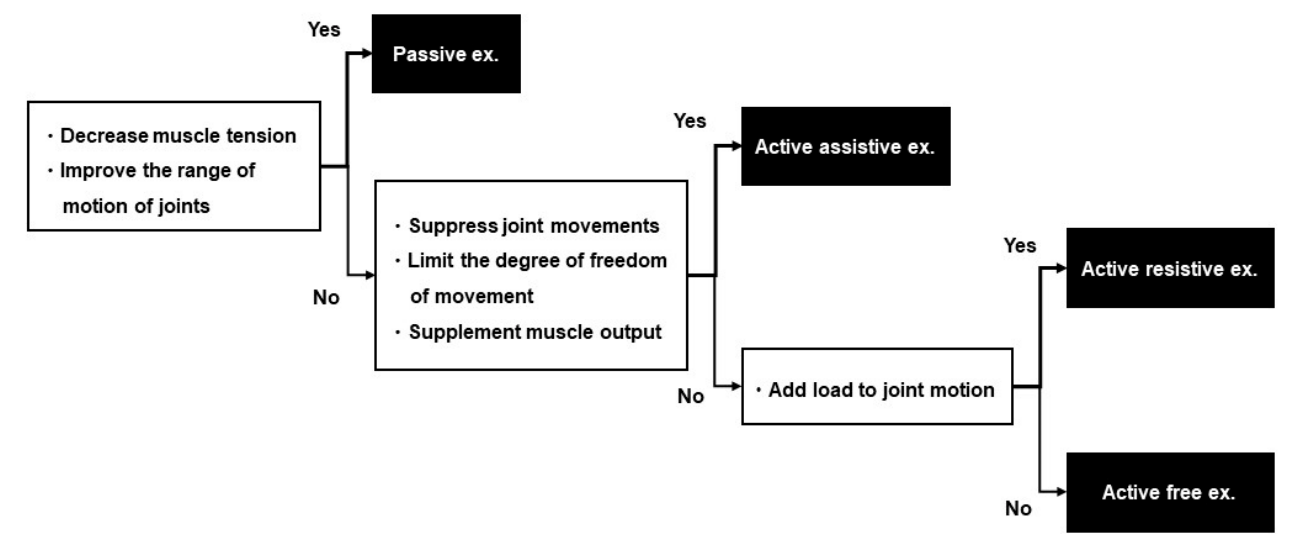
Figure 5. Chart of methods to determine the amount of practice assistance. A method for determining the amount of assistance for performing functional exercises is presented. Passive exercise is selected when the goal is to decrease muscle tension and improve the range of motion of joints. Active assistive exercise is selected when the patient wants to suppress joint movements, limit the degree of freedom of movement, and supplement muscle output. Active resistive exercise is selected to add load to joint motion. Active free exercise is selected to perform upper-extremity movements without adding load to the joint motion.